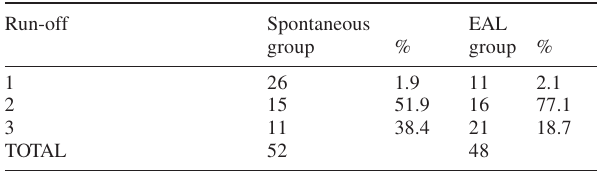
Table 6 - Number of open run-off vessels Run-off